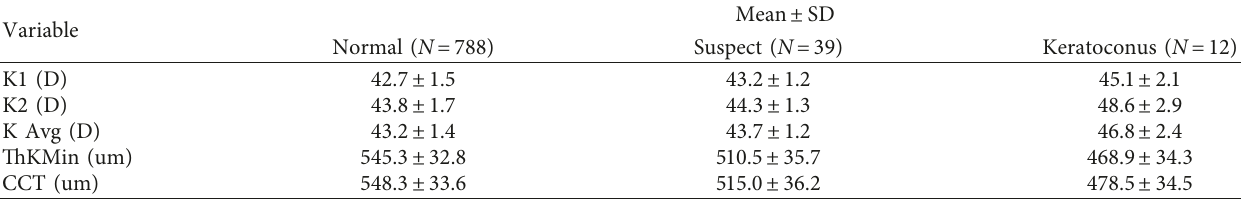
Table 2: Bivariate summary statistics of the outcome (patient outcome) and continuous explanatory variables. Variable